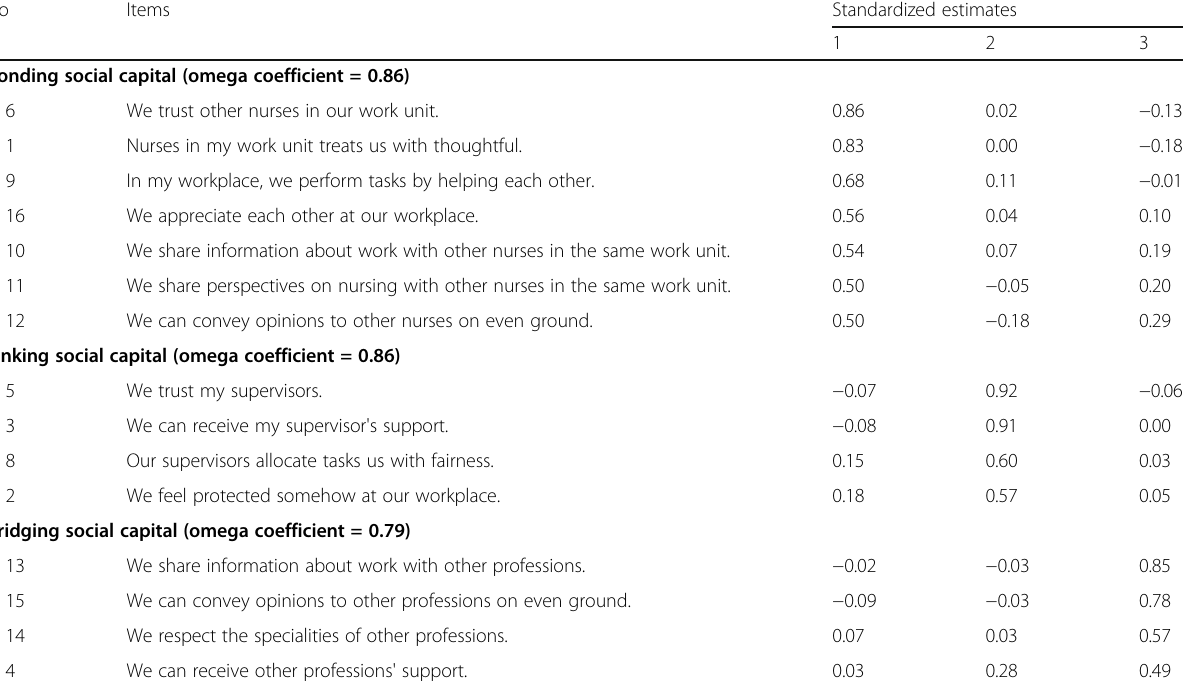
Table 3 Final factor pattern of the RWSCS-JN